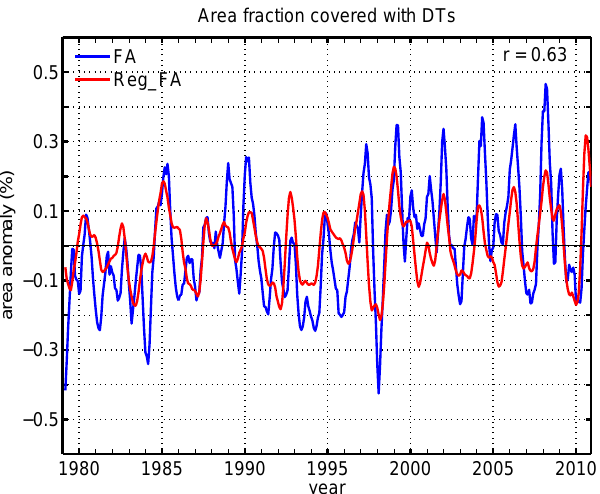
Fig. 1. The blue curve represents the monthly anomalies of the fraction of area (FA) associated with DTs within the 20 ◦ –65 ◦ N and 20 ◦ –65 ◦ S latitude bands. The red curve represents the multilinear regression of the FA anomalies onto the time series of the QBO, ENSO and solar cycle. Both curves were smoothed by a 5-month running average. The correlation between the two time series is r = 0 .